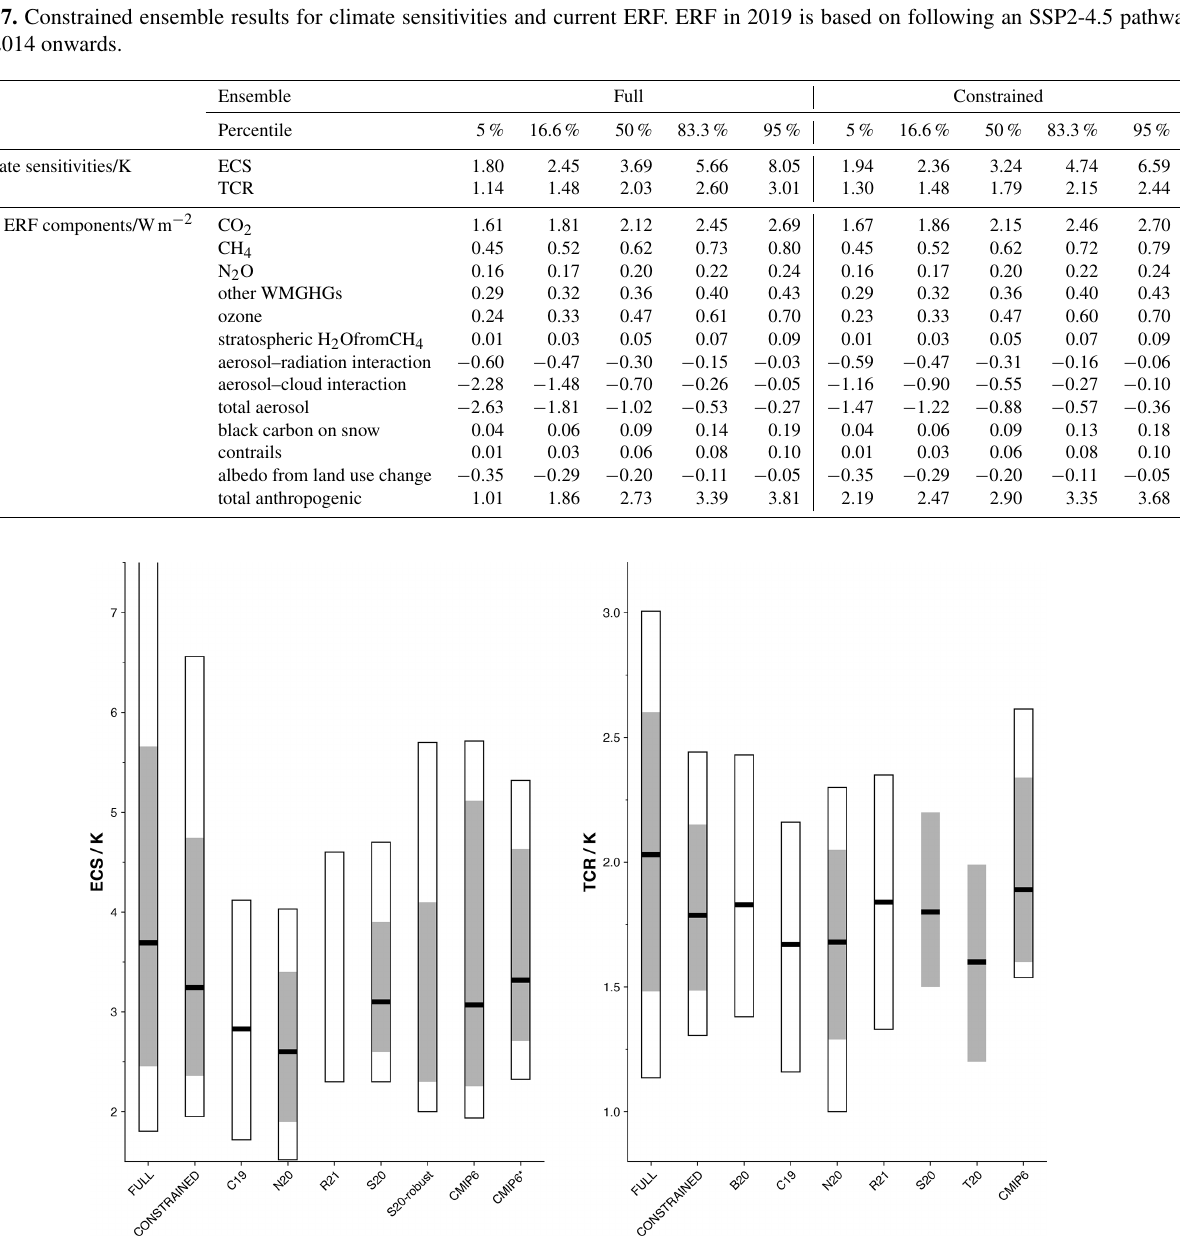
Figure 6. Climate sensitivities of our full and constrained ensembles in the context of other studies. The black line indicates median values, the grey shading shows the likely range, and unfilled bars show the 5%–95% range. Studies included are as follows: Brunner et al. (2020, B20), Jiménez-de-la Cuesta and Mauritsen (2019, C19), Nijsse et al. (2020, N20), Ribes et al. (2021, R21), Sherwood et al. (2020, S20), Tokarska et al. (2020, T20). CMIP6 indicates climate sensitivities derived from the energy balance model fits calculated in Sect. 3.1 (including ocean heat uptake efficacy); CMIP6* indicates climate sensitivities derived using the Gregory method (Gregory et al., 2004) over the first 150 years of the abrupt-4xCO2